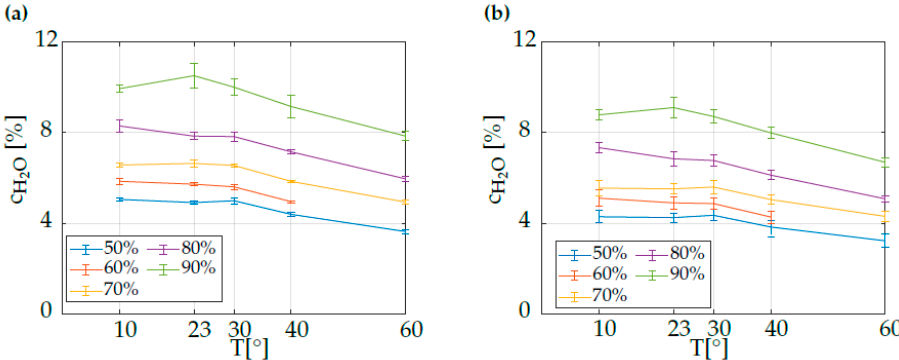
Figure 3. Moisture content during adsorption in dependence of the temperature for different relative humidity for 70 g/m 2 ( a ) and 50 g/m 2 metalized paper ( b ).